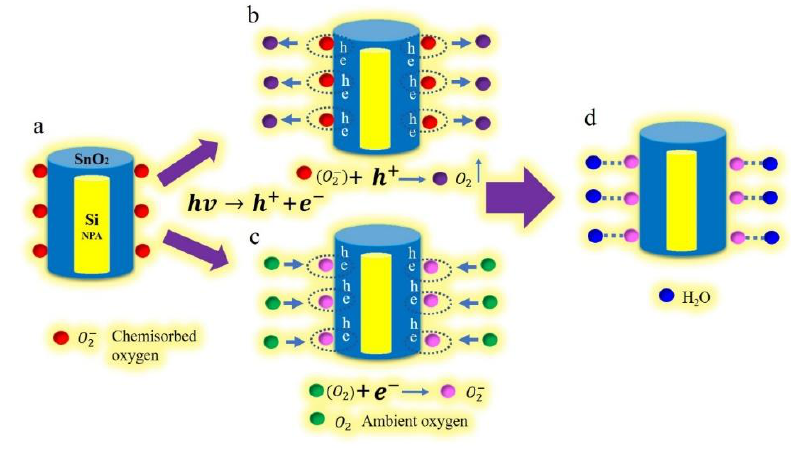
Figure 5. The UV-activated humidity sensing mechanism of the silicon nanopillar array sensor.